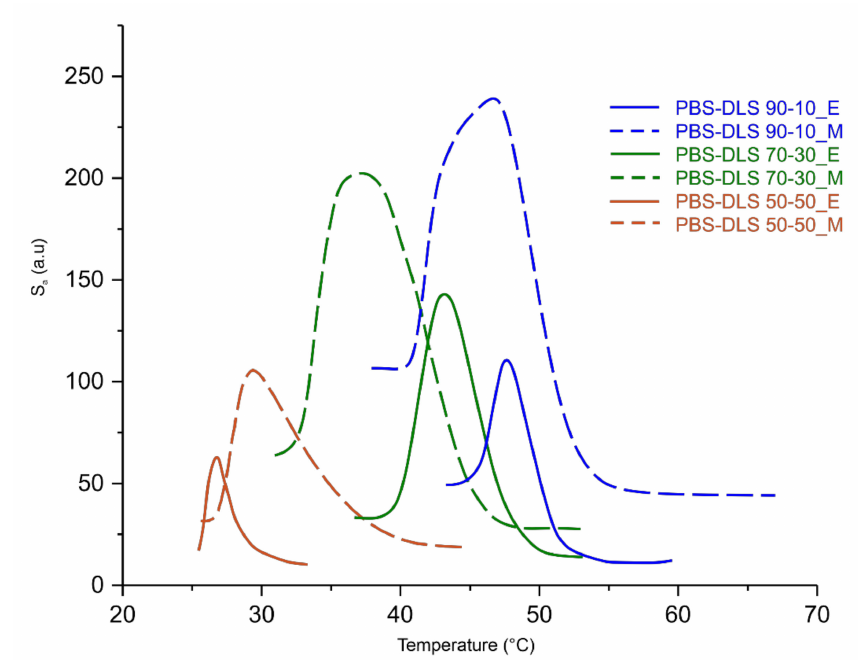
Figure 12. Roughness of the samples (S a ) during cooling from the melt. To investigate the crystalline properties of the PBS-DLS copolyesters more deeply, X-ray diffraction (XRD) analysis was performed using melt-pressed thin polymer films. As presented in Figure 13, we noticed two strong reflections at 2 θ = 19.7 ◦ (d = 4.50 A , α (020/111)) and 22.8 ◦ (d = 3.90 A , α (110)), shoulder at 2 θ = 22.1 ◦ (d = 4.05 A , α (021)), and two extra peaks appeared with lower intensities at 2 θ = 26.3 ◦ (d = 3.38 A , α